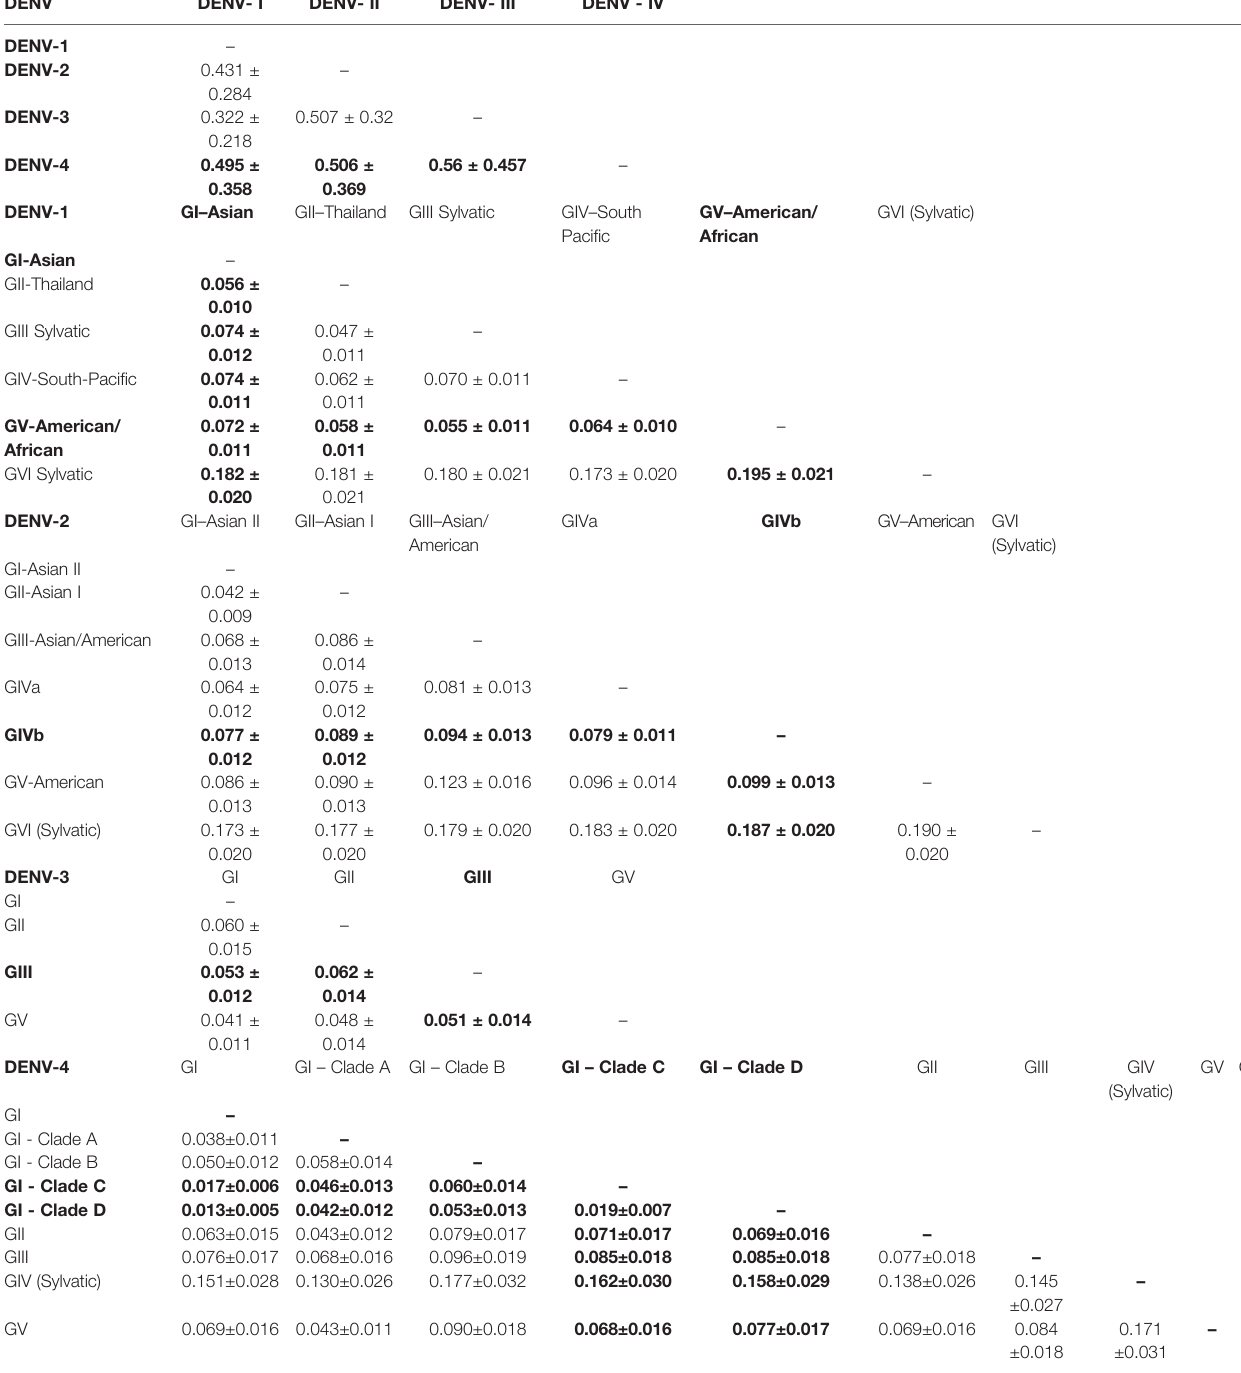
The genetic (p) distance matrix corresponding to the DENV sequence alignment. The number of base differences per site from averaging over all sequence pairs between groups and standard error are shown. The relative observations for our isolates in genotypes are given in bold. p, genetic